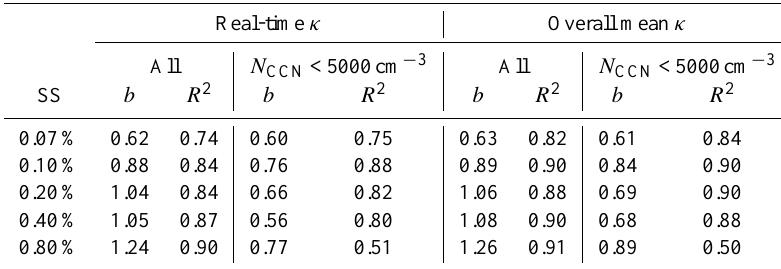
Table 4. Fitting parameters of the linear regression results in Fig.